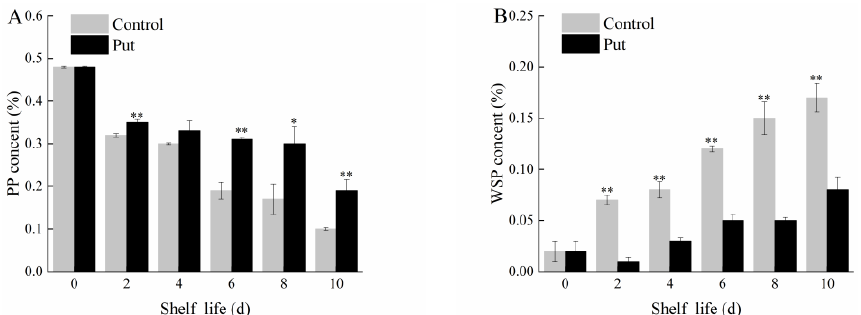
Figure 4. Changes in PP ( A ) and WSP ( B ) of postharvest blueberry fruit at 20 °C. Mean ± SE of three replicate experiments are shown. Asterisks indicate significant differences between control and Put − treated fruit (* p < 0.05, ** p < 0.01).